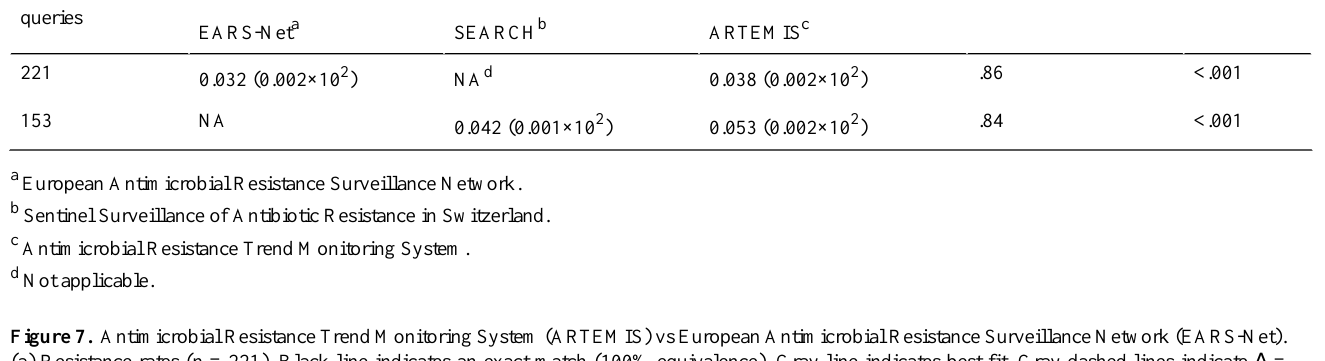
Figure 7. Antimicrobial Resistance Trend Monitoring System (ARTEMIS) vs European Antimicrobial Resistance Surveillance Network (EARS-Net). (a) Resistance rates (n = 221). Black line indicates an exact match (100% equivalence). Gray line indicates best fit. Gray dashed lines indicate Δ = ±0.130. (b) Resistance rates without outliers (n = 213). (c) Gray vertical dashed lines indicate similarity region Δ . Gray horizontal bars indicate